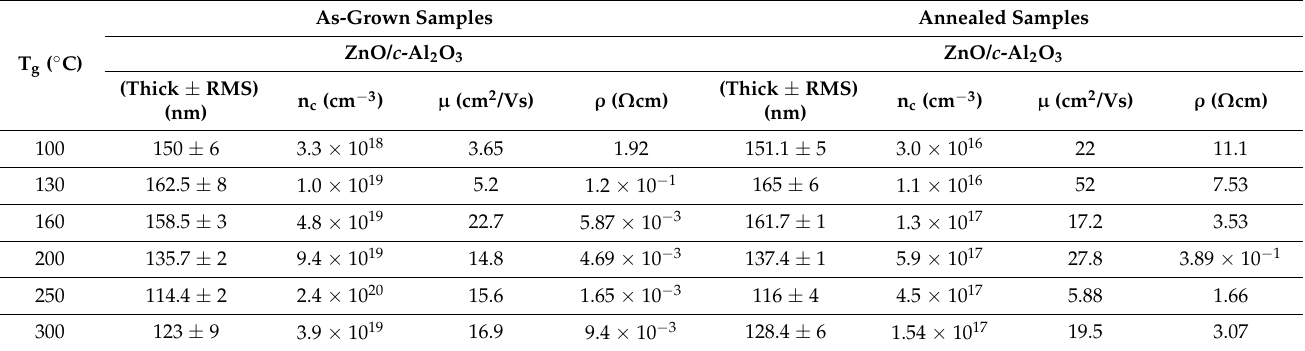
Thin ZnO/ a - A l 2 O 3 films: The resistivity of the as-grown films also lie in the range of (~1 – 10 −3 ohm-cm) and successively decreases till T g = 200 °C. After 3 min of annealing at 800 °C, the resistivity value increases up to (~0.9 – 9.6 ohm-cm) with no systematic varia- tion with T g (Figure 4a). The carrier concentration (n) of the as-grown films lies in the range n = 10 18 – 20 cm −3 , being the same as that observed in ZnO/ c -Al 2 O 3 , but decreases by 1 – 4 orders of magnitude (n = 10 16 −1 8 cm −3 ) after RTA. The mobility (µ) values of the as-grown